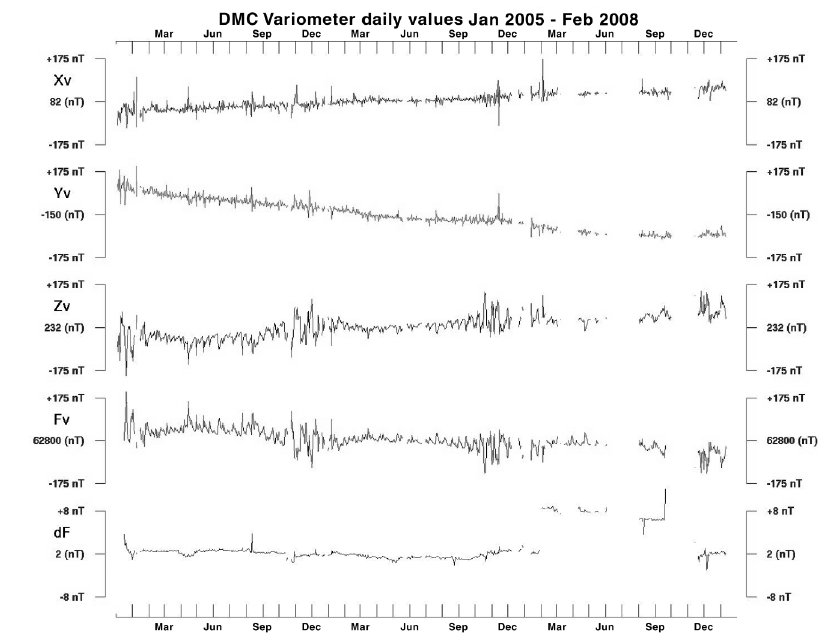
Fig. 9. Daily mean values of the magnetometer outputs. Xv, Yv, Zv, stand for the components measured in the sensor reference frame (close to the local magnetic reference frame). Fv is the total field recorded by the proton magnetometer. dF is the difference F recorded minus F computed where F computed is the intensity of the field resulting from the combination of the magnetometer outputs and the base lines. The jump of dF in the range March 1 – mid-September 2007 is due to a move of the sensor of the scalar magnetometer.